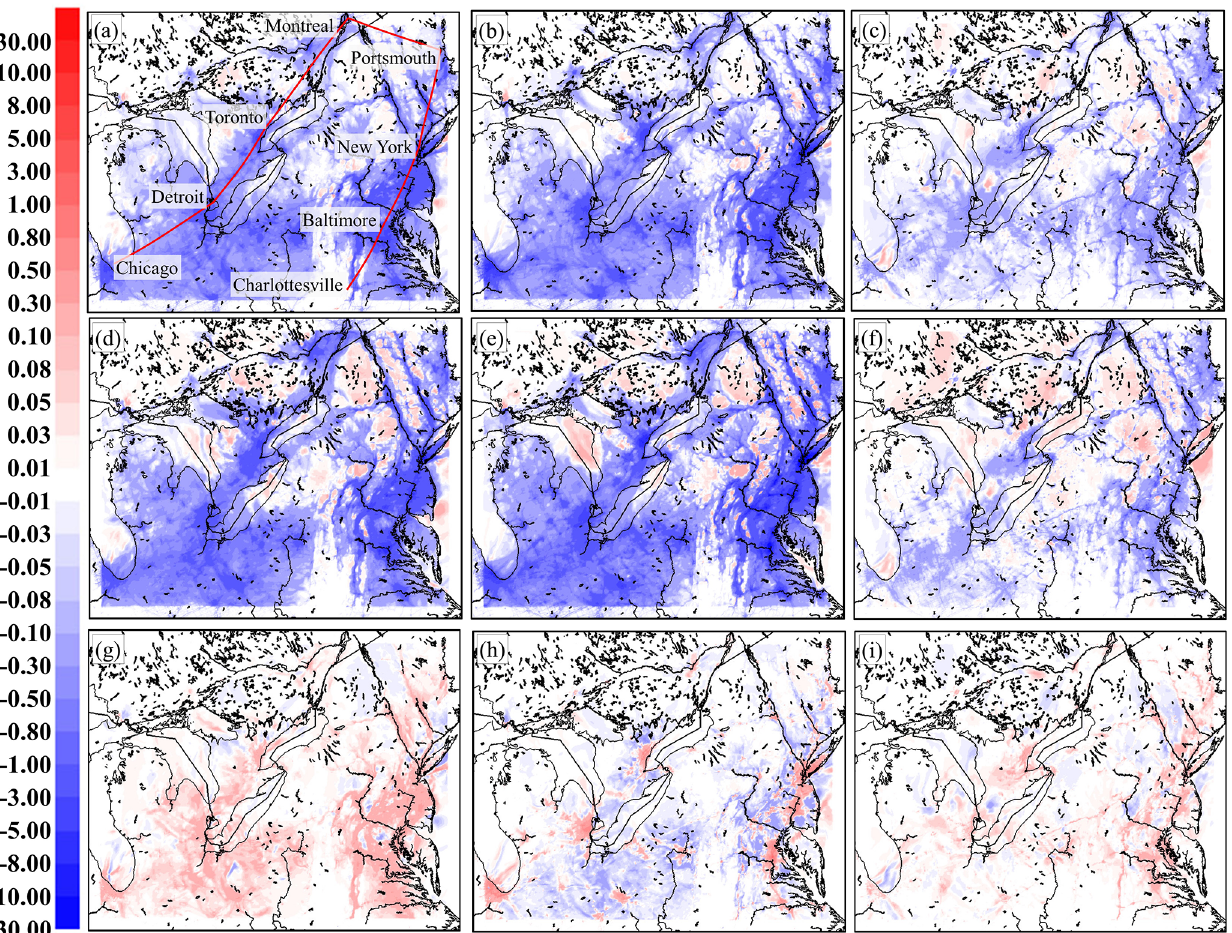
Figure 10. Difference in 30d average surface NO 2 , PM 2 . 5 , and O 3 , January 2016, in the Pan Am 2.5km grid cell size domain simulation. Averages are paired at 10:00, 14:00, and 22:00UTC according to species; (a–c) : (cid:49) NO 2 ; (ppbv) (d–f) (cid:49) PM 2 . 5 (µgm − 3 ); (g–i) (cid:49) O 3 (ppbv). Red line in (a) indicates the position of the vertical cross section shown in Fig.